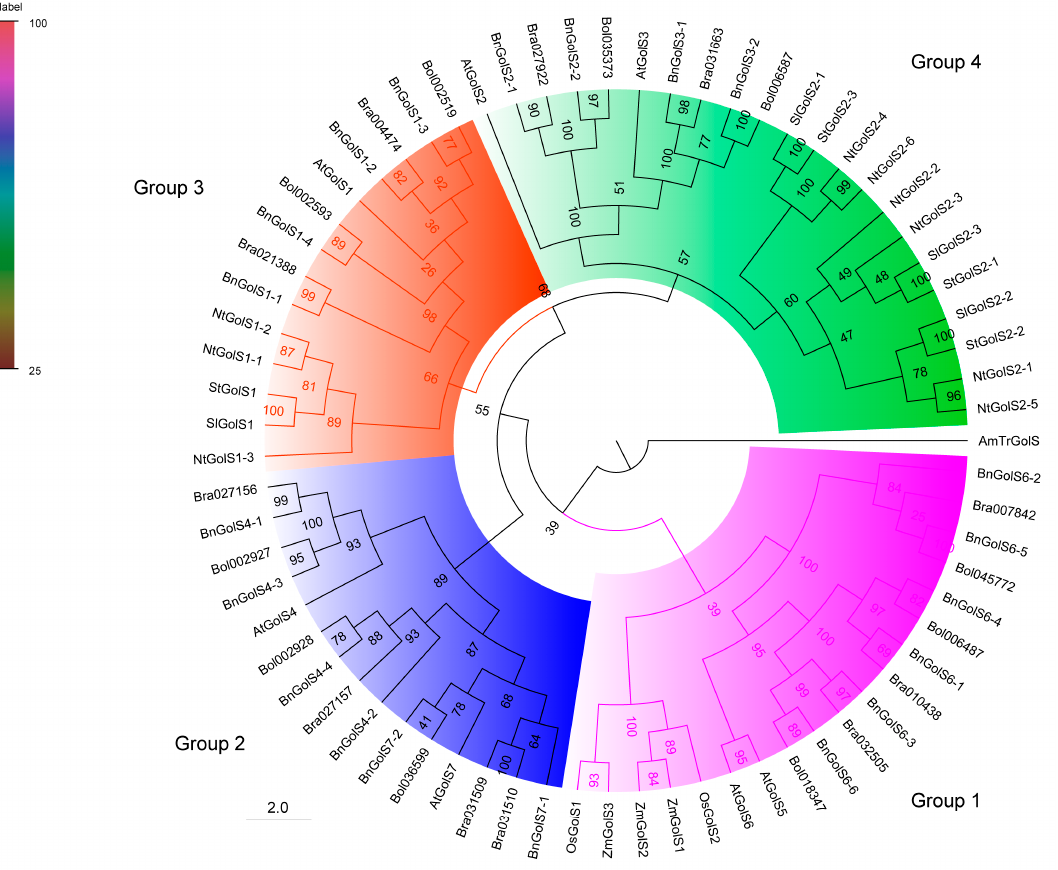
Figure 2. Phylogenetic relationship among GolS proteins in plants. The ML tree was generated with bootstrap analysis (100 replicates) using aligned GolS protein sequences from A. thaliana , B. napus , B. rapa , B. oleracea , N. tabacum , S. lycopersicum , S. tuberosum , O. sativa and Z. mays (GolS in A. trichopoda